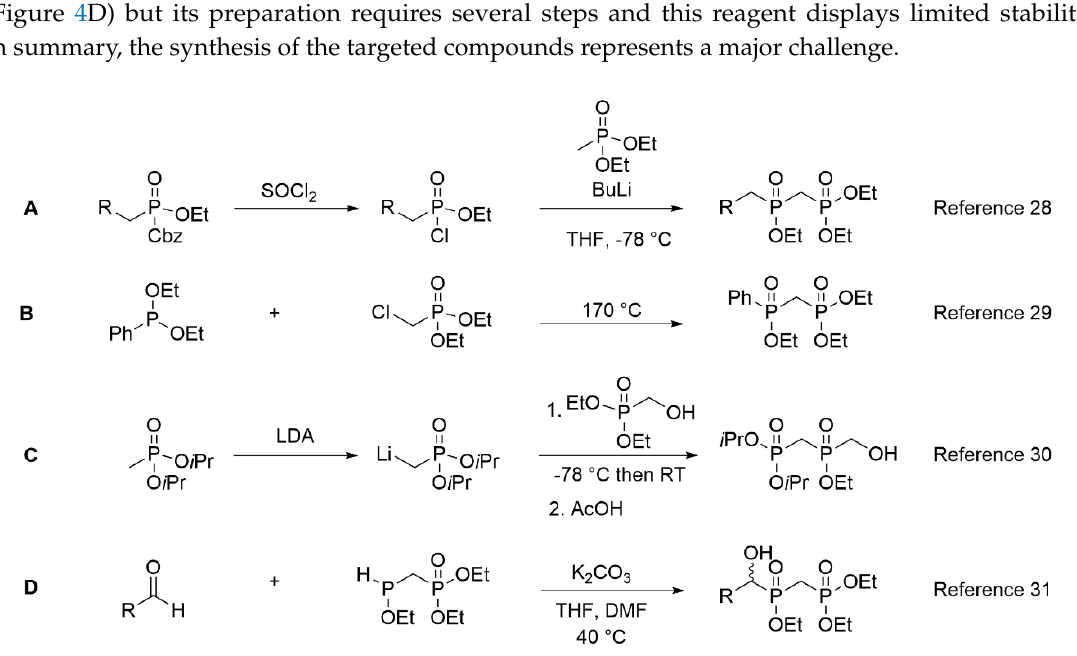
Figure 5. Retrosynthetic analysis.